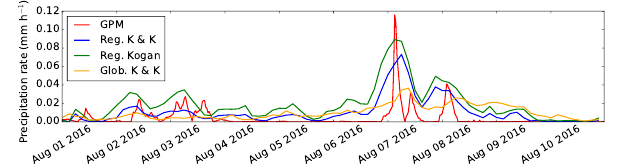
Figure 11. Domain mean precipitation rate in the regional and global models, in mmh − 1 , compared with the GPM dataset (Huff- man et al., 2014). The effect of the biomass burning aerosol on rain is shown later, in Fig.